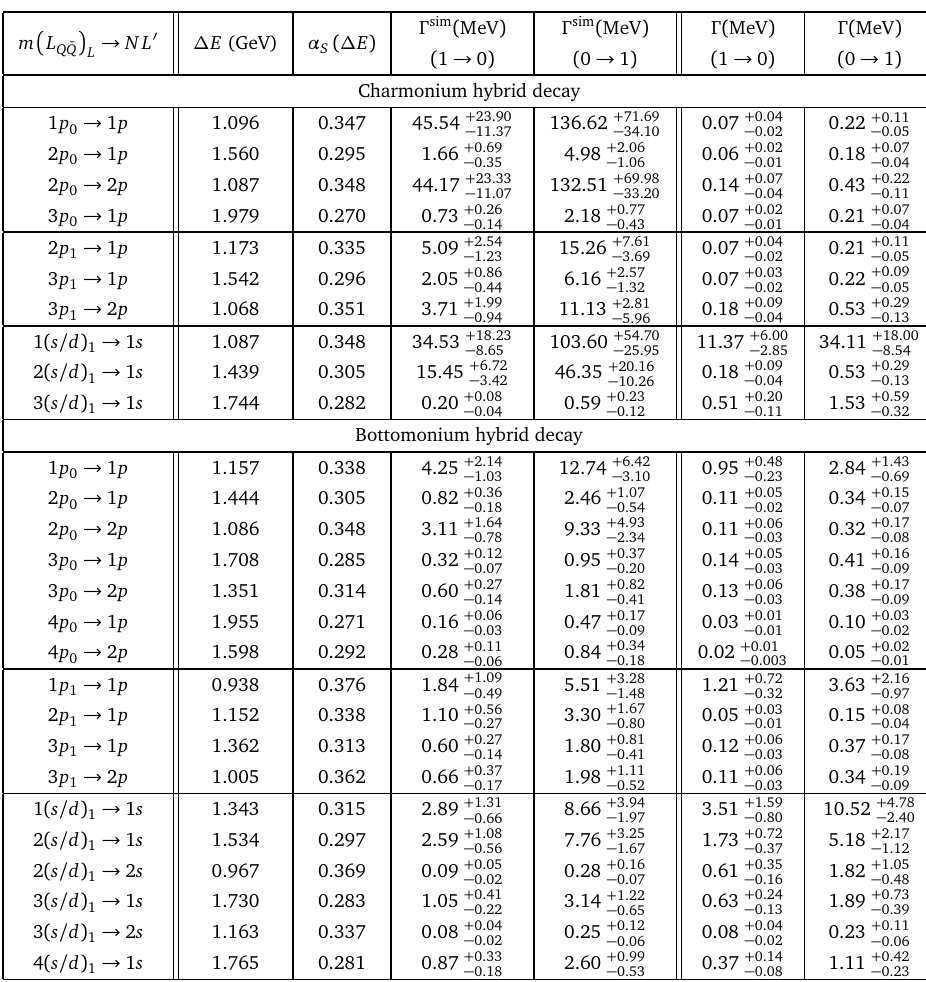
Table 2: Preliminary results for the spin-flipping inclusive decay rate for hybrids decays to traditional quarkonium states: H in Eq. (13). The decay rate in fourth and fifth column is computed using Eq. (20) and in last two column using Eq. (17). The notation ( 1 → 0 ) denotes spin-1 hybrid decaying into spin-0 quarkonium while ( 0 → 1 ) denotes spin-0 hybrid decaying into spin-1